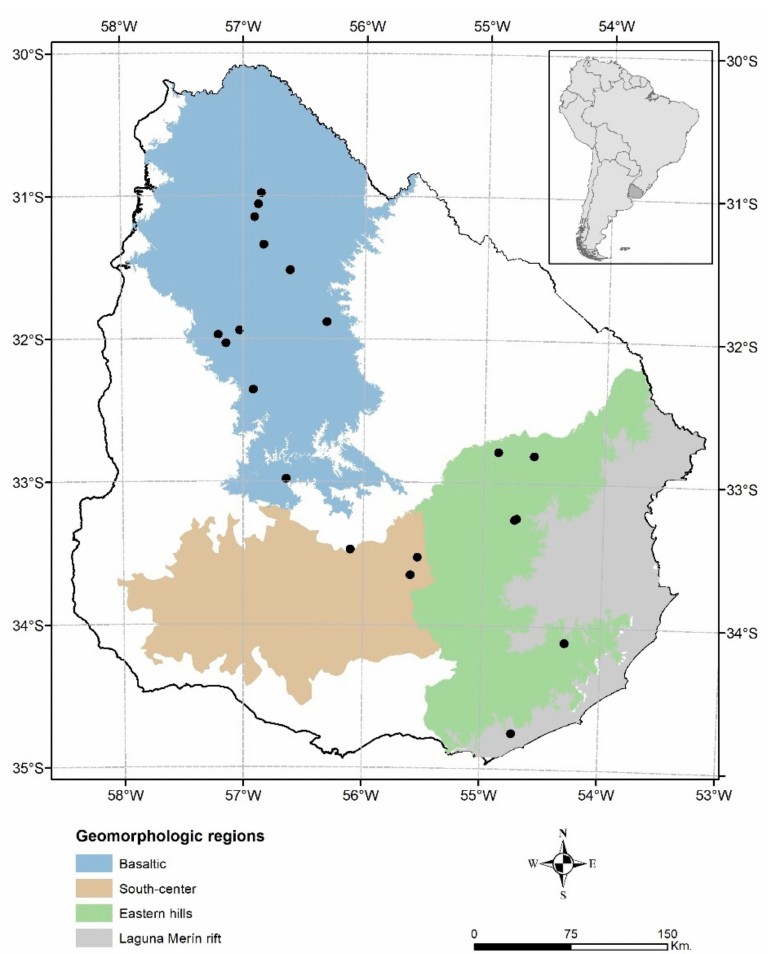
Figure 1. Location of studied commercial pastoral livestock farms in four geomorphologic regions of